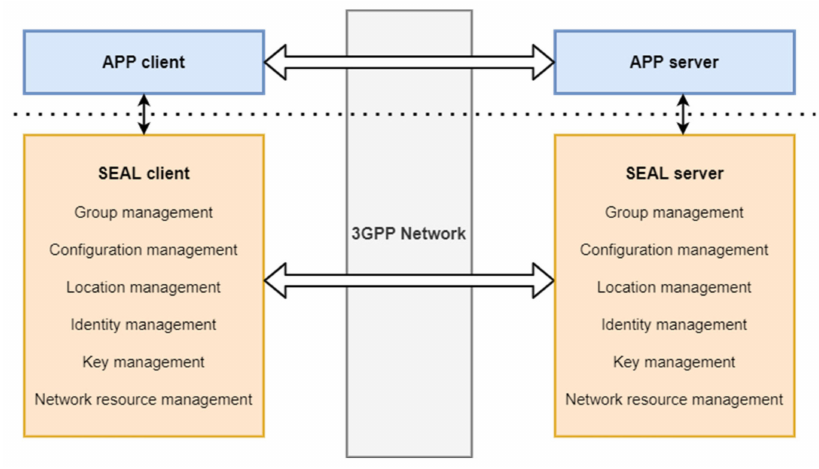
Figure 9. Simplified functional model of SEAL Architecture, 3GPP TS